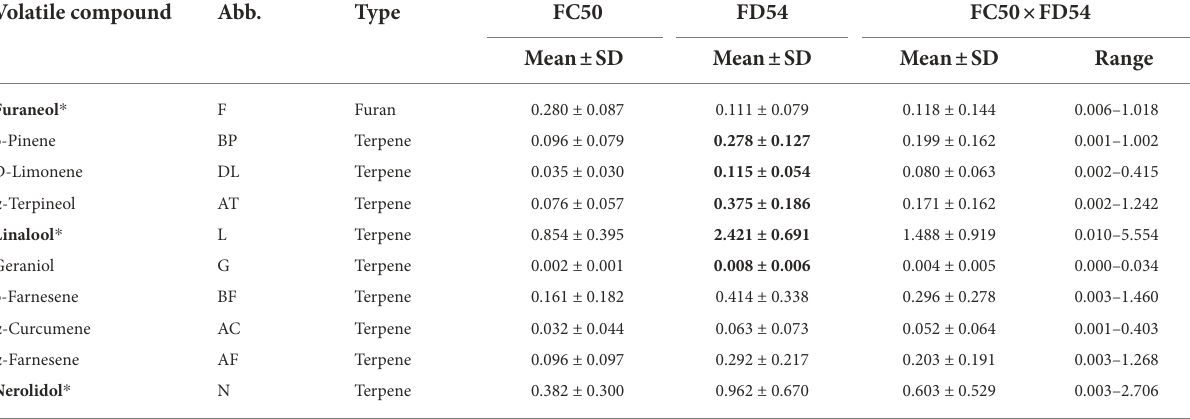
(Figure 2). Most of the lines (64%), were grouped together in a big cluster A, which is separated into two subclusters, A1 and